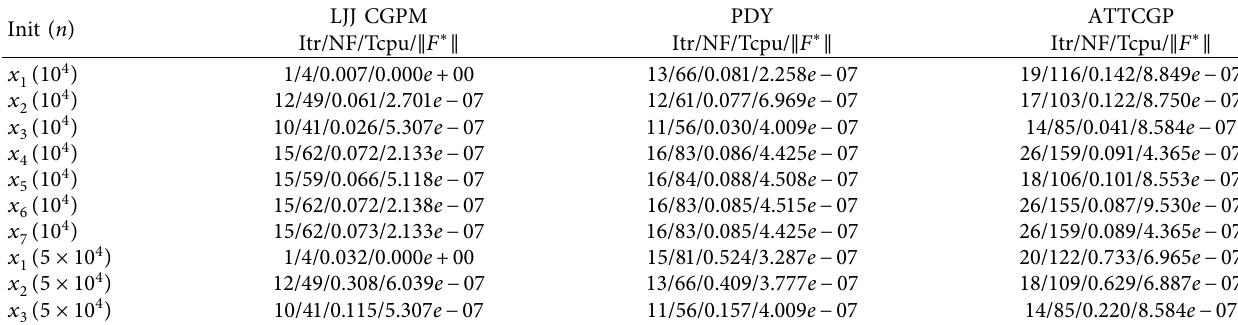
Table 7: Numerical results on Problem